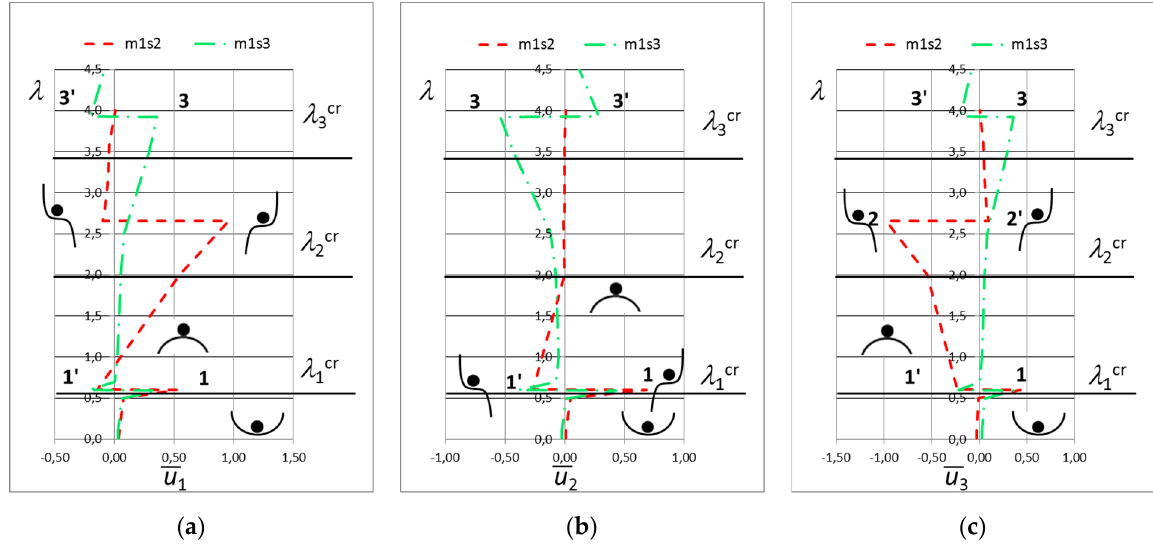
Figure 15. Equilibrium path obtained for geometrical imperfections in the shape of: small amplitude of the first buckling mode, medium amplitude of the second or third buckling mode, respectively ( m 1 s 2 or lub m 1 s 3); displacement of the node: ( a ) No. 1, ( b ) No. 2, ( c ) No. 3.